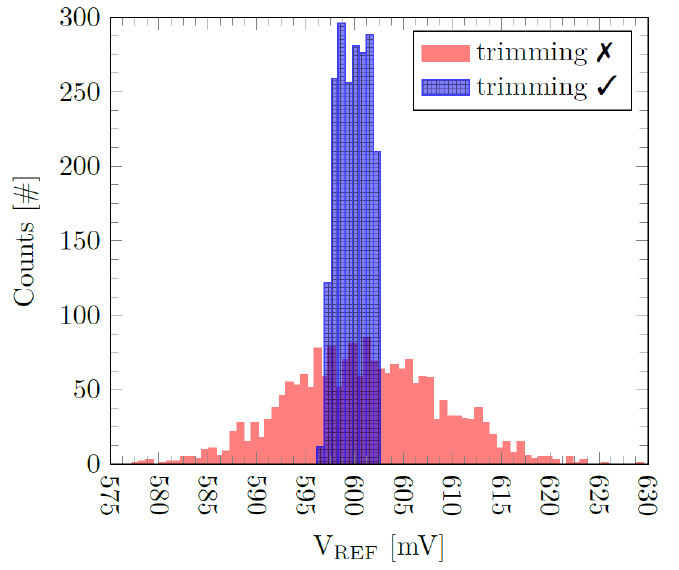
Figure 11. Combined histogram of Monte Carlo V REF with (grid) and without trimming (solid) at 27 ◦ C and 1.2 V of